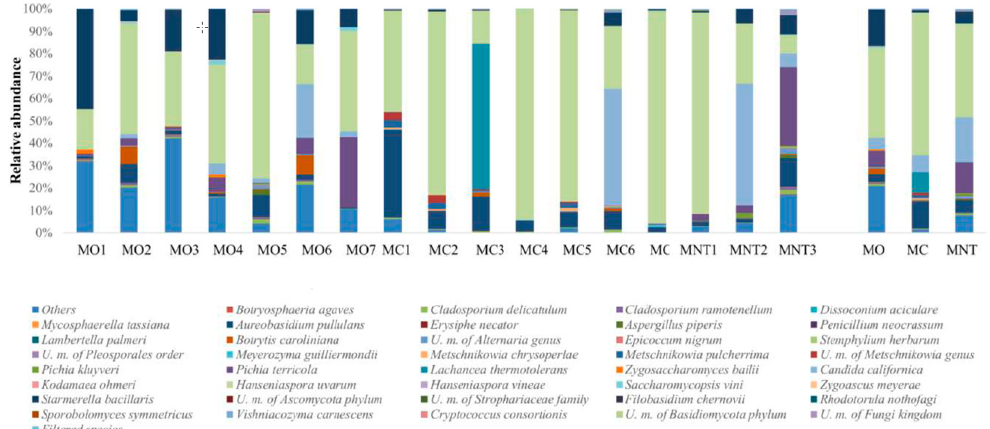
Figure 4. Relative abundance of fungal community detected by NGS at the 7 th day of spontaneous fermentation in organic (MO), conventional (MC) and not treated (MNT) samples. The number associated to the samples represent the replicates for each treatment. In the microorganism legend, U.m. abbreviation means undefined microorganism. Only the taxa >0.5% are shown, and the taxa ≤ 0.5% are grouped under heading Filtered species of the legend. To the right of the graph, mean values of each treatment are represented (MO, MC and MNT).